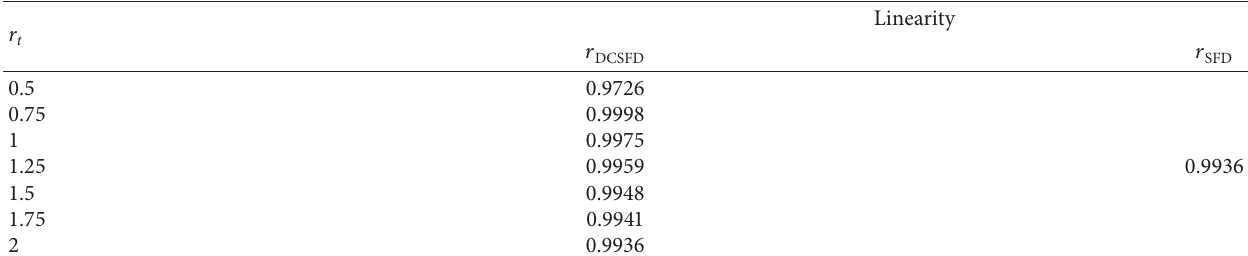
r : (a) radial film force; (b) circumferential film force. t on DCSFD Table 1: The influence of r r t on DCSFD